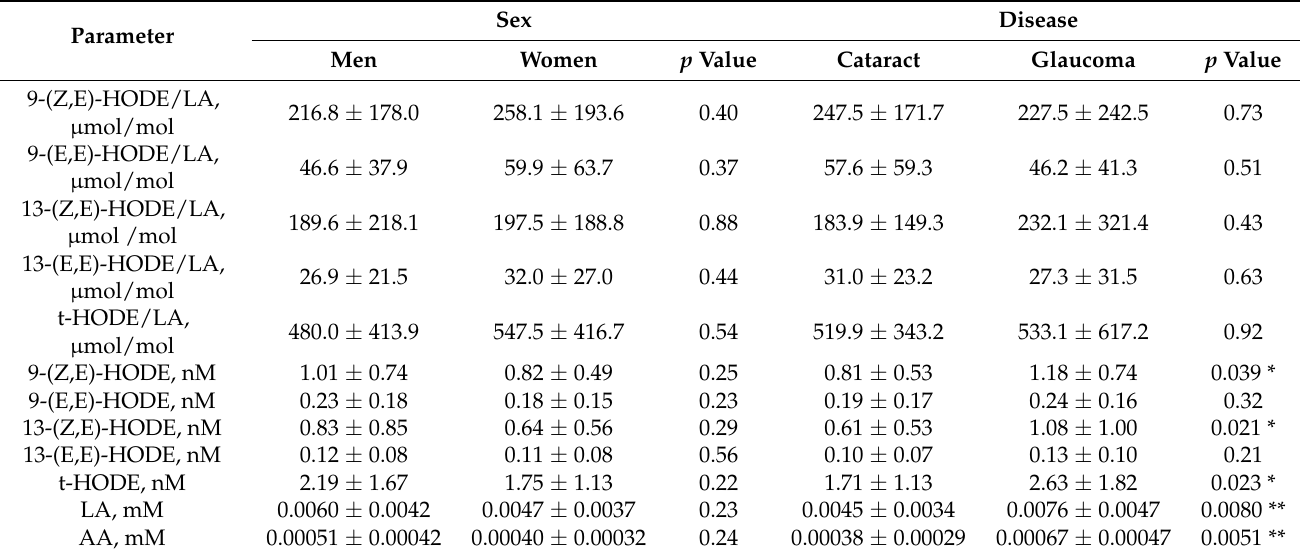
Table 4. Possible association between HODE levels and sex or disease type.